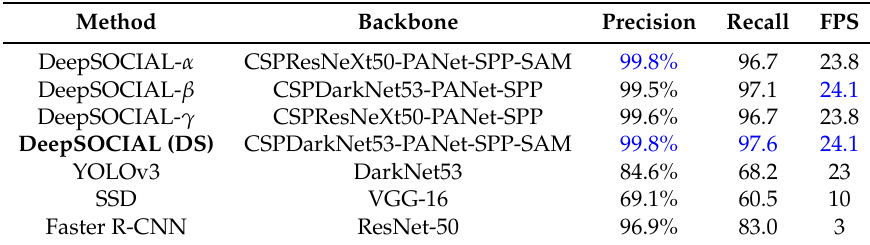
Table 3. Accuracy, recall-rate, and speed comparison for seven Deep Neural Network (DNN) models on the Oxford Town Centre dataset.